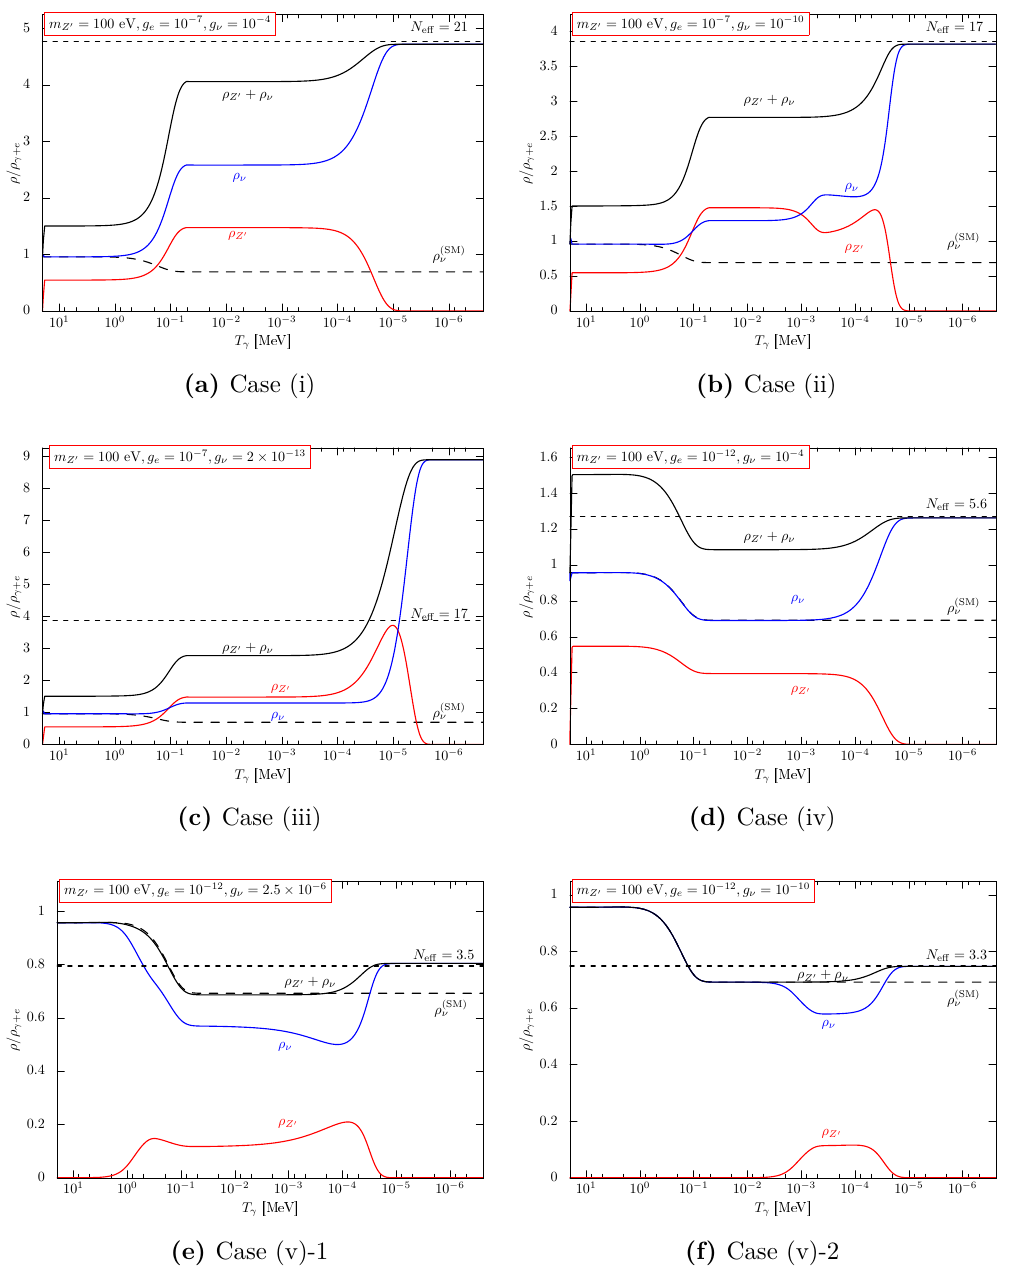
Figure 4. Time evolution of the energy densities which show the similar behaviors of the Cases